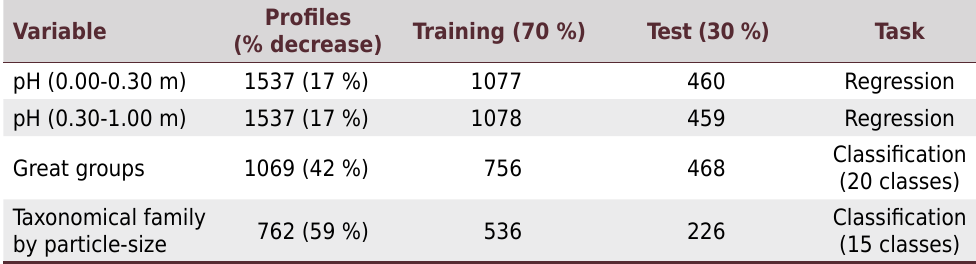
Table 4. Number of soil profiles per target variable after preprocessing and related task type. The decrease is based on an initial 1858 profiles